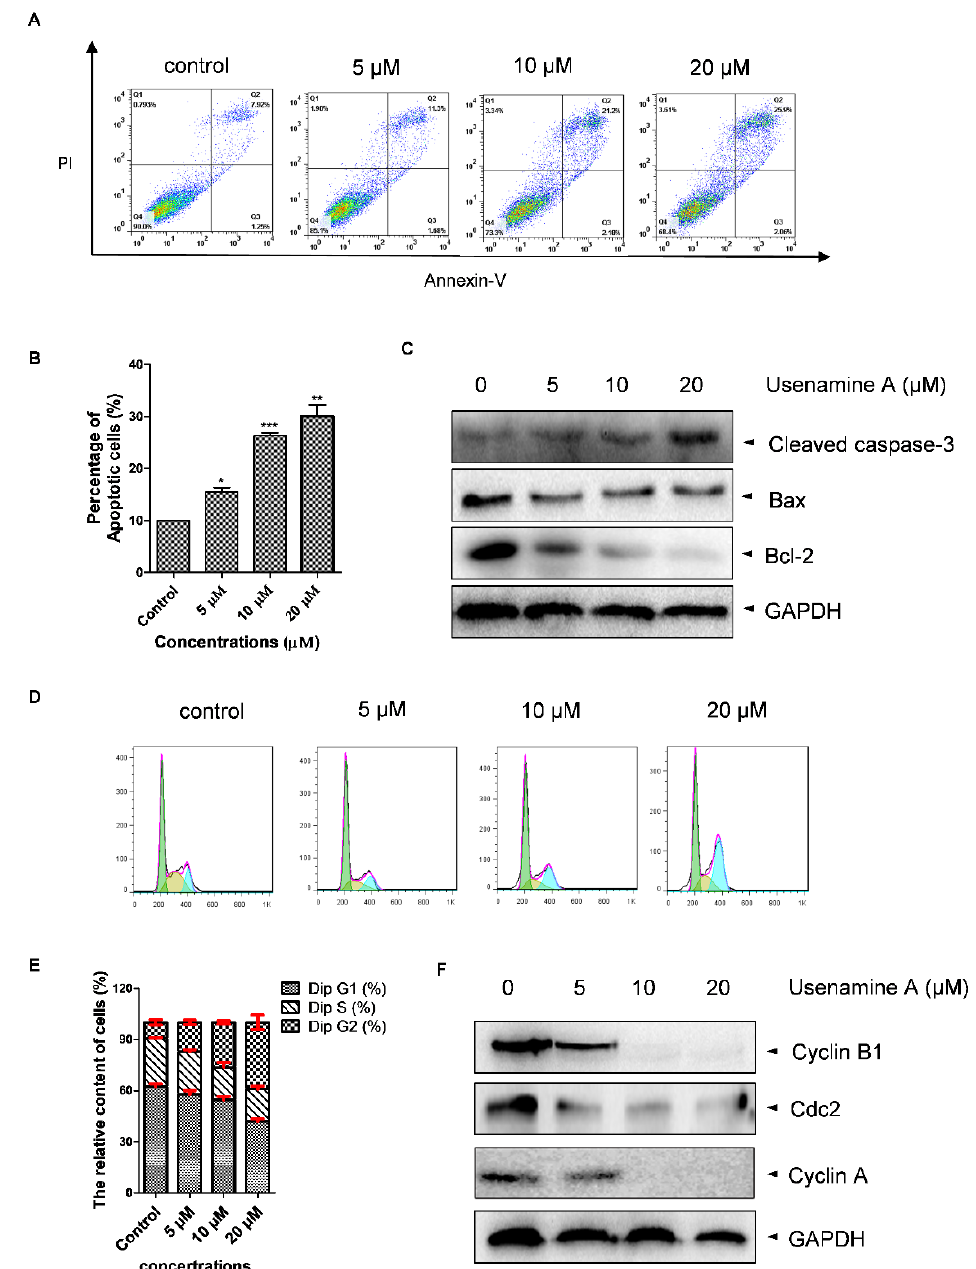
Figure 4. Apoptosis and cell cycle distribution analyses of MDA-MB-231 cells treated with usenamine A. ( A , B ) Apoptosis as determined by flow cytometry analysis following treatment with usenamine A (0, 5, 10, 20 µ M) for 48 h. The apoptosis rate is the sum of the early and late apoptosis rates. ( C ) Representative western blot of apoptosis-related proteins. Data are representative of three independent experiments or are presented as the mean ± SD of three independent experiments. ( D , E ) Cell cycle distribution as examined by flow cytometry analysis following treatment with usenamine A (0, 5, 10, 20 µ M) for 48 h. ( F ) Representative western blot of G2/M-related proteins. Fetal bovine serum (FBS) was used as a supplement to culture MDA-MB-231 cells. Values indicate mean ± SD of three independent experiments. * p < 0.05, ** p < 0.01 and *** p < 0.001 compared to the control